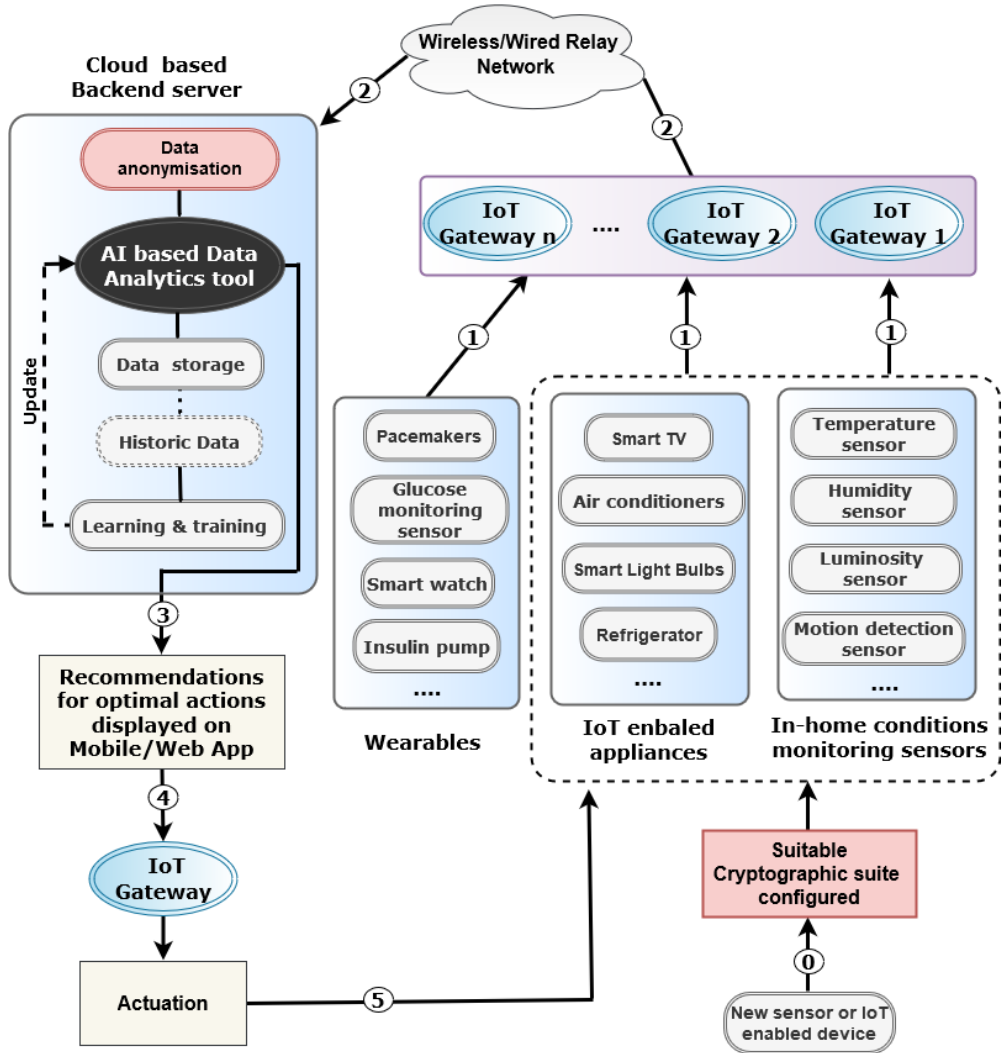
Figure 1. Architecture of a secure and privacy-preserving IoT-based sensing and actuation system in a smart